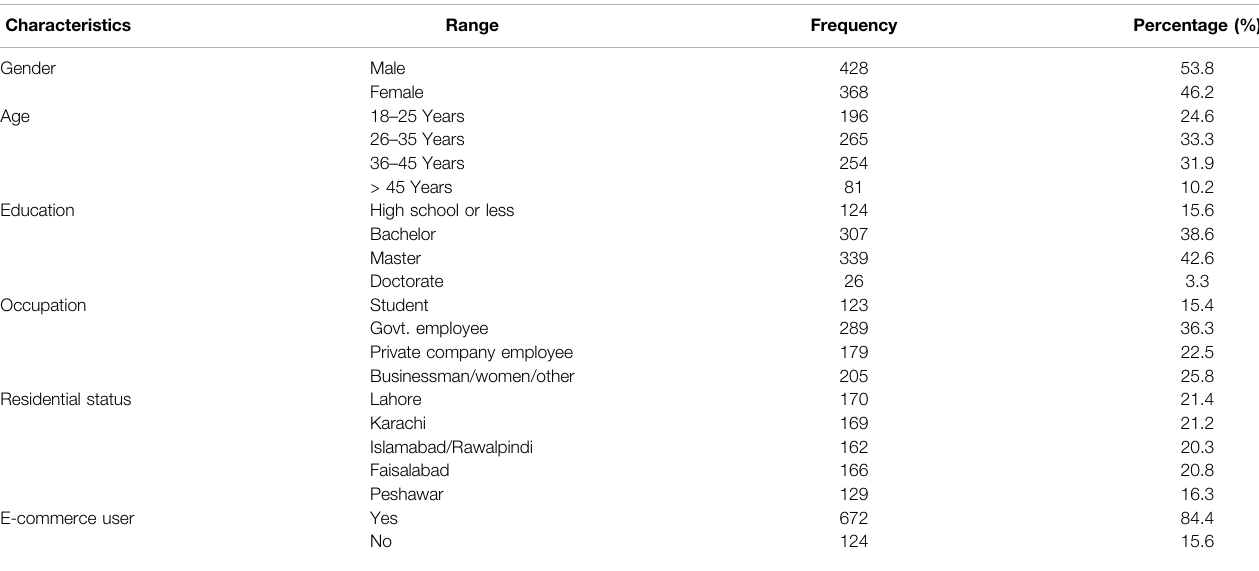
TABLE 1 | Demographic